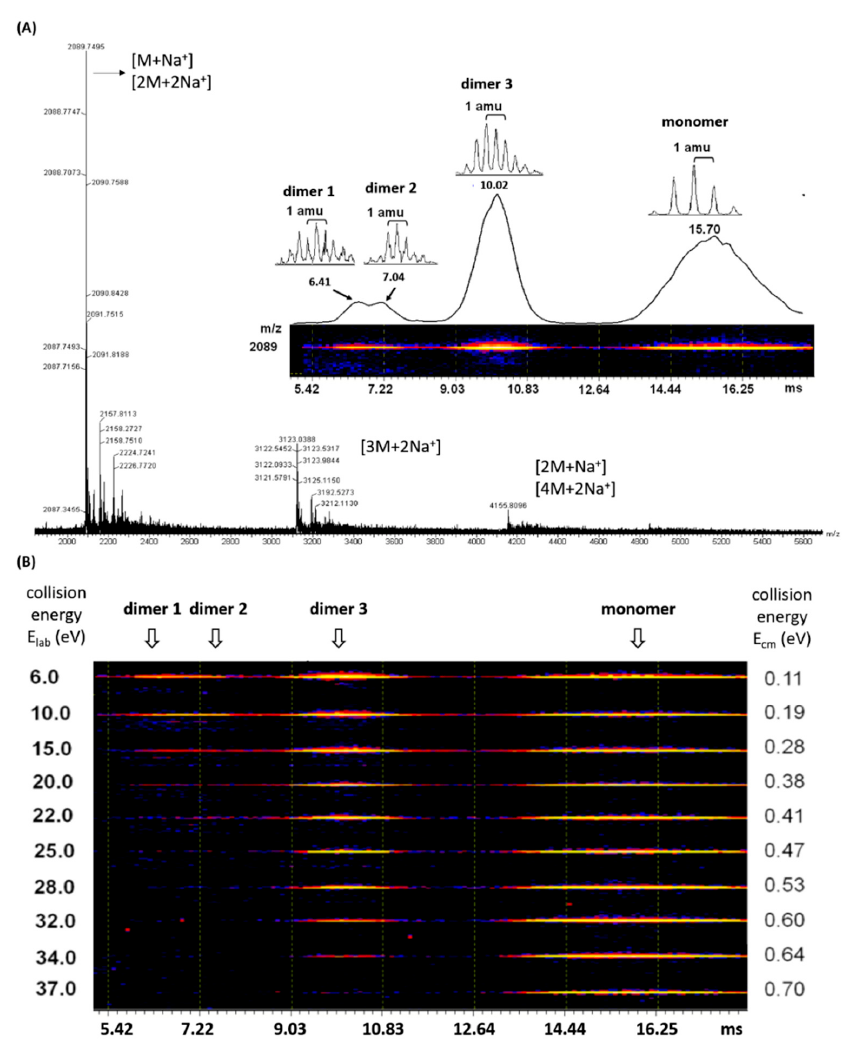
Figure 2. ( A ) ESI mass spectrum of BPOSS-PDI-C 60 . ( B ) Two-dimensional ESI-TWIM-MS plot of BPOSS-PDI-C 60 for m/z = 2087 showing different types of dimers and the monomer at the drift time of 6.41, 7.04, 10.02 and 15.70 ms, respectively.